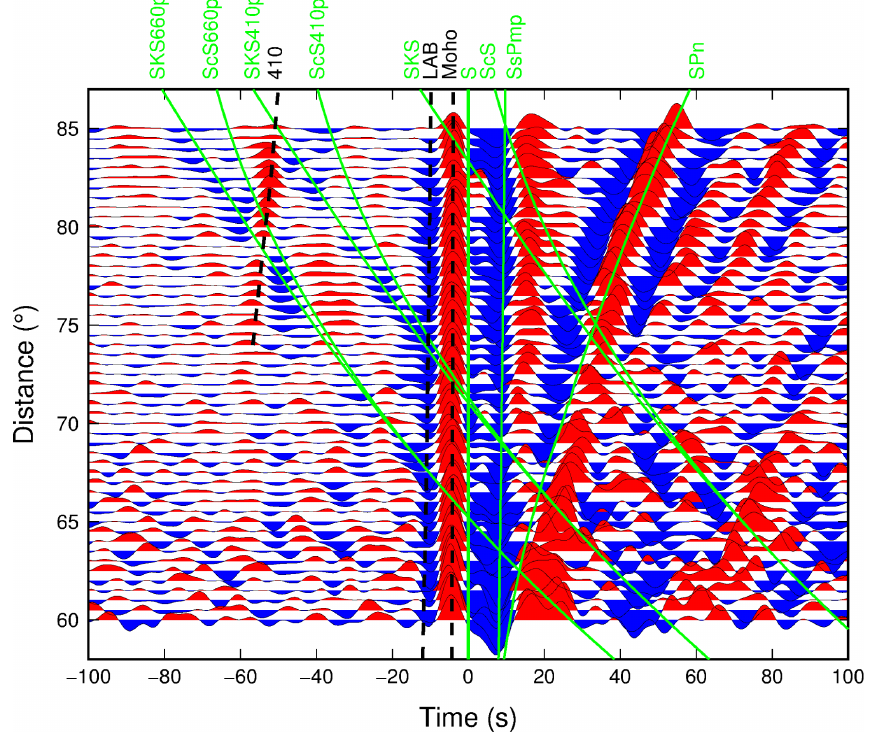
Figure 3. Stacks of all 11660 S-receiver functions as a function of the epicentral distance (binned in 0.5 ◦ distance windows). The traces are lined up along the theoretical arrival time of the SV phase. Data are deconvolved and filtered with a 8s low-pass filter. Theoretical arrival times of several phases are